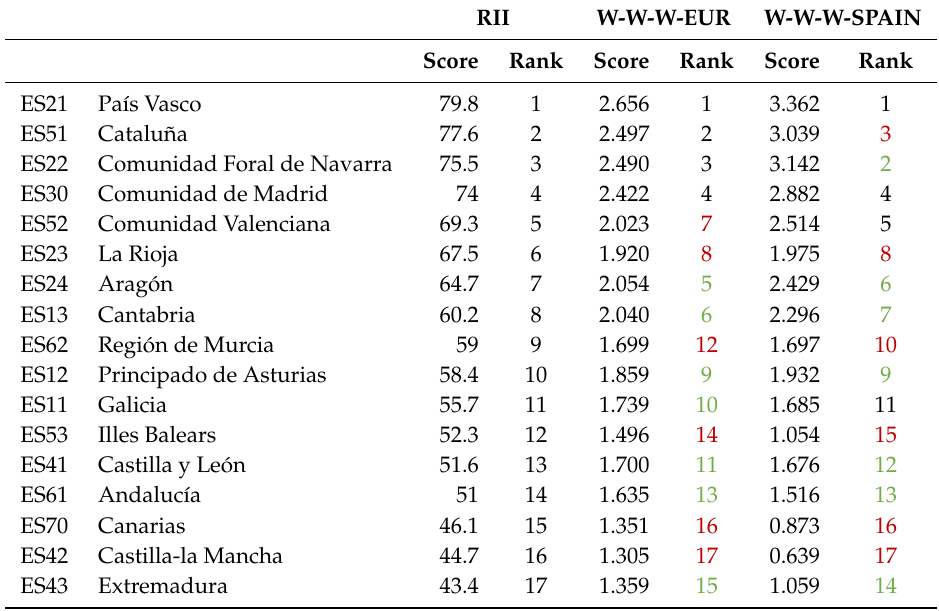
Table 5. Scores and ranks of the Spanish regions for the RII, W-W-W (European lelvels) and W-W-W (Spanish levels) indicators. Rank improvements (with respect to RII) are colored in green, and rank impairments are colored in